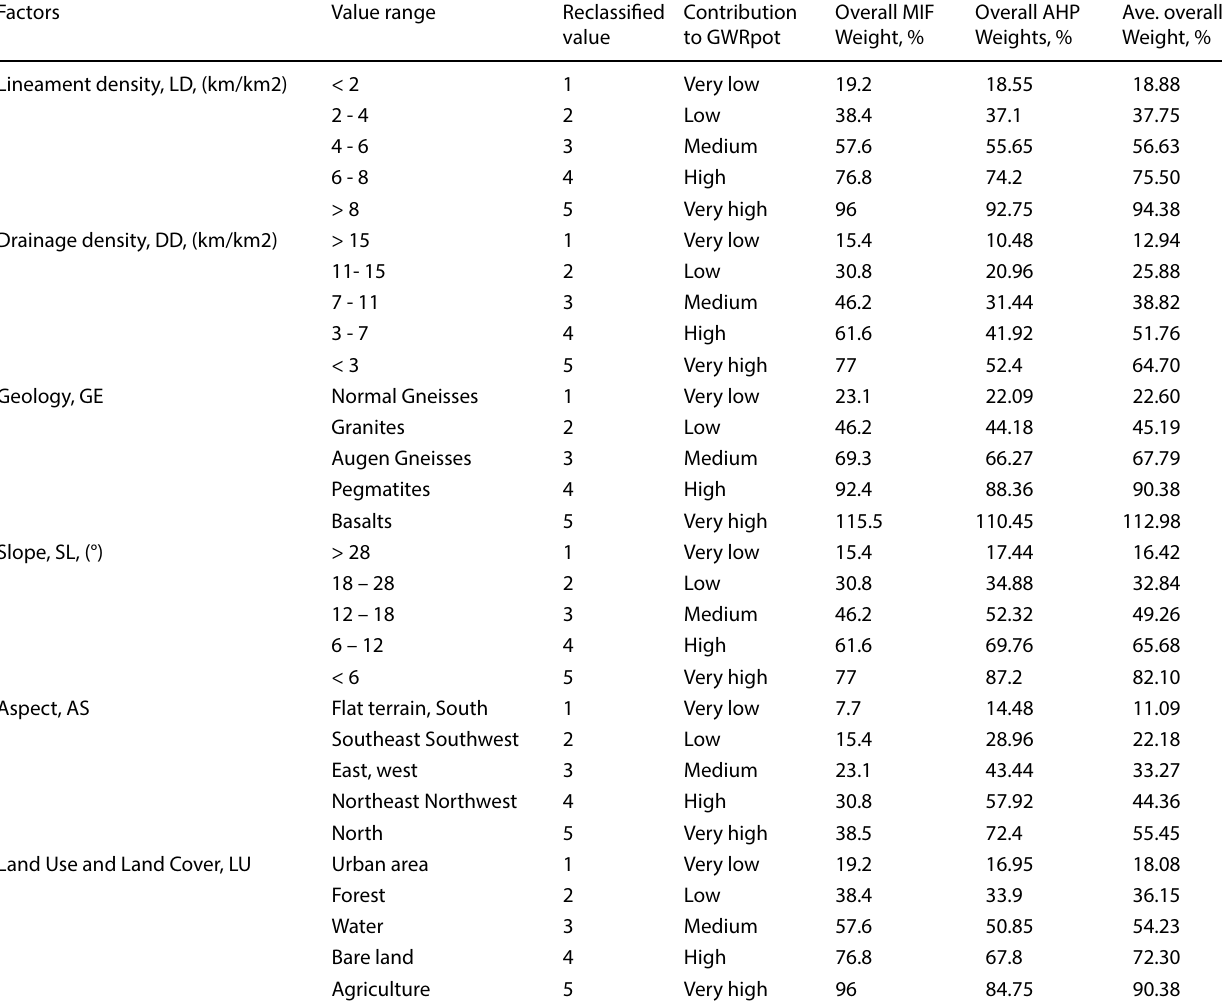
Table 4 Reclassified values of the value ranges of each factor. The overall MIF weight is obtained from the product of factor class reclassified value and factor MIF weight. The overall AHP weight is obtained from the product of factor class reclassified value and factor AHP